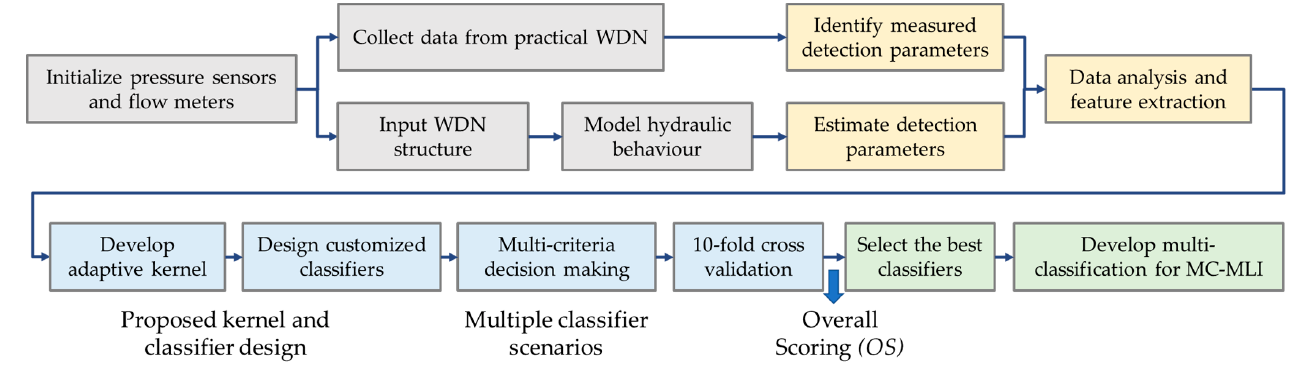
Figure 1. The development flow of the proposed multi-classification multi-leak identification (MC- MLI) scheme.